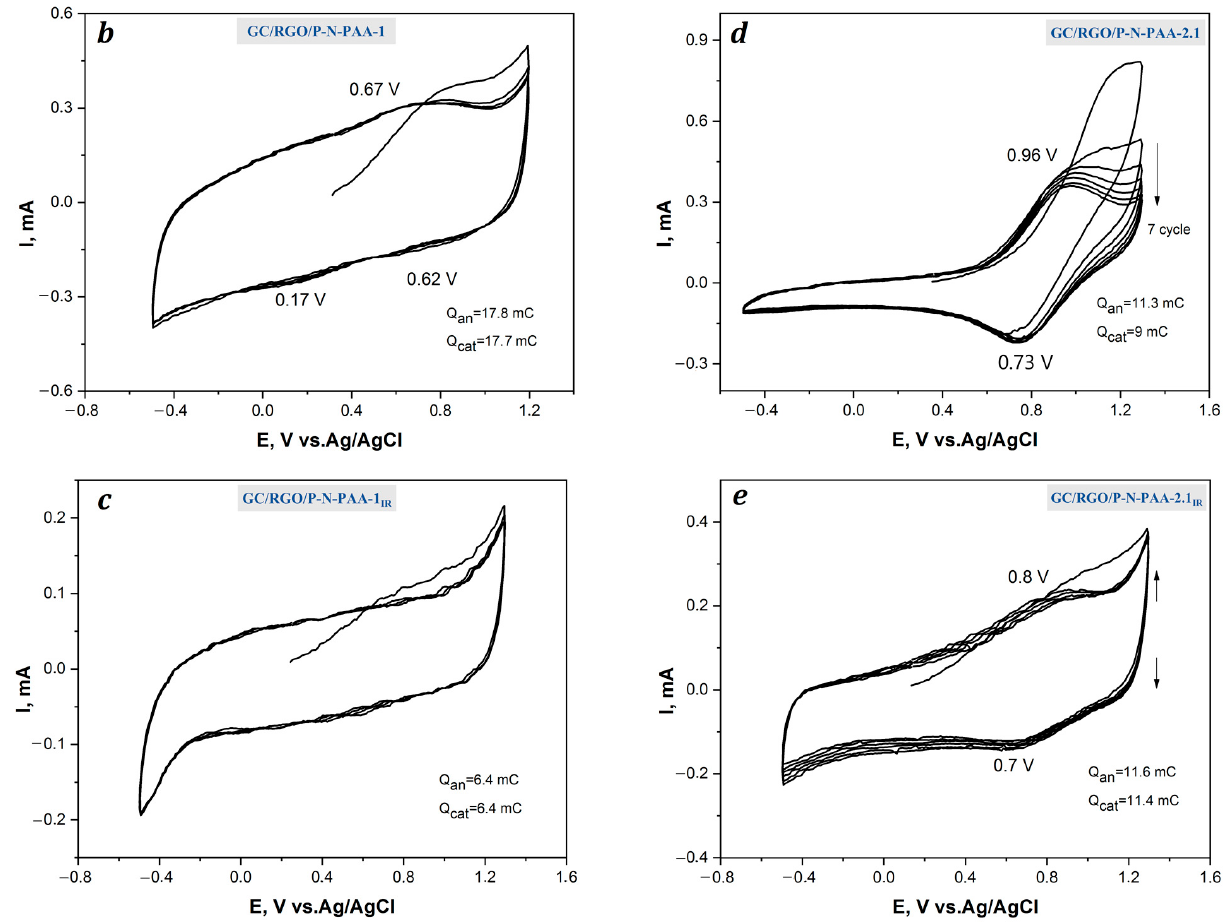
Figure 9. ( a ) CV curves of GC (1a), GC/P-N-PAA (2a), and GC/RGO/P-N-PAA ( b – e ) at the potential scan rate of 20 mV·s –1 .